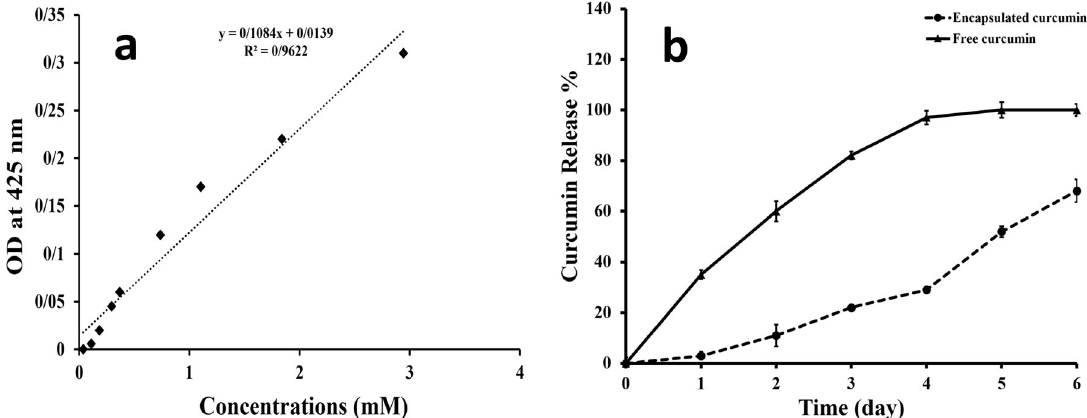
and encapsulated curcumin indicates the lower slope for the encap- sulated curcumin due to the controlled release of curcumin ( b )